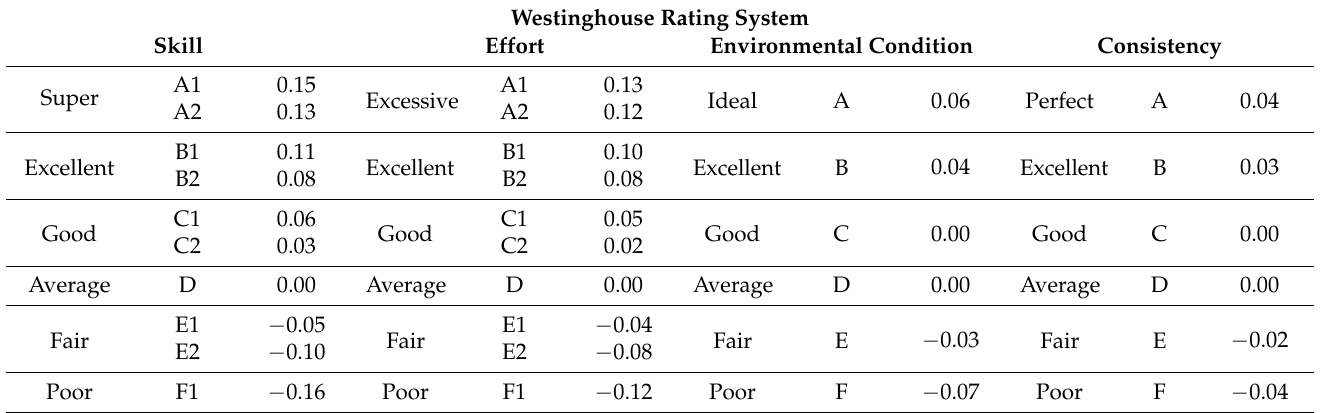
Table 2. Factors of Westinghouse rating